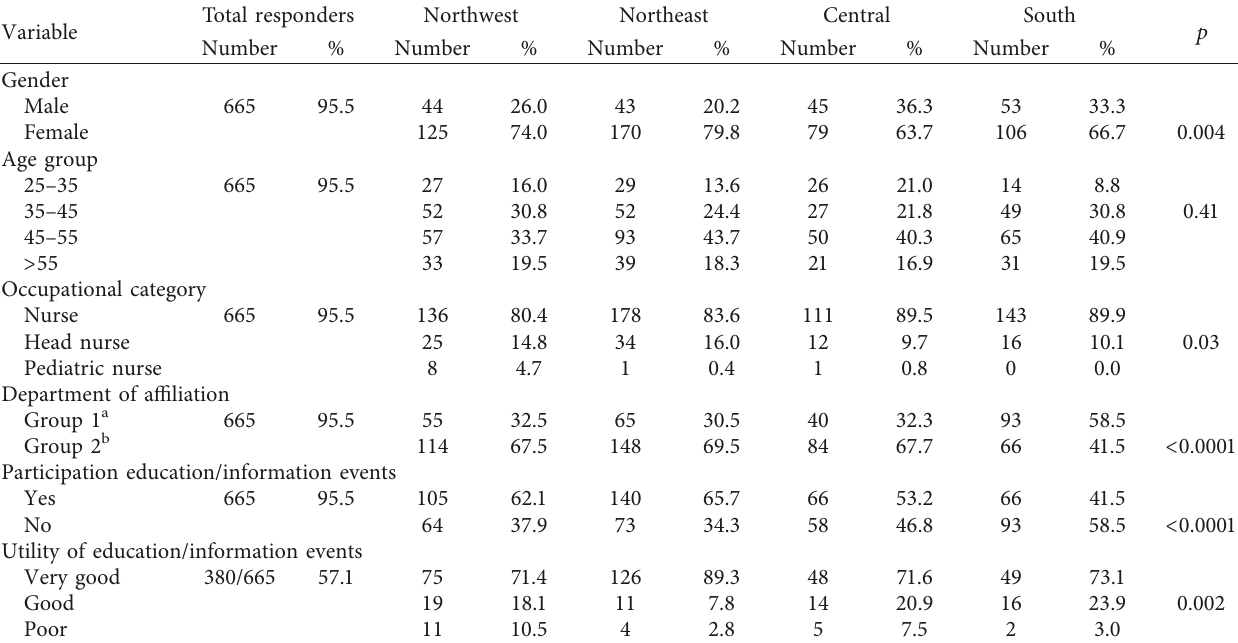
Table 1: Distribution of participant